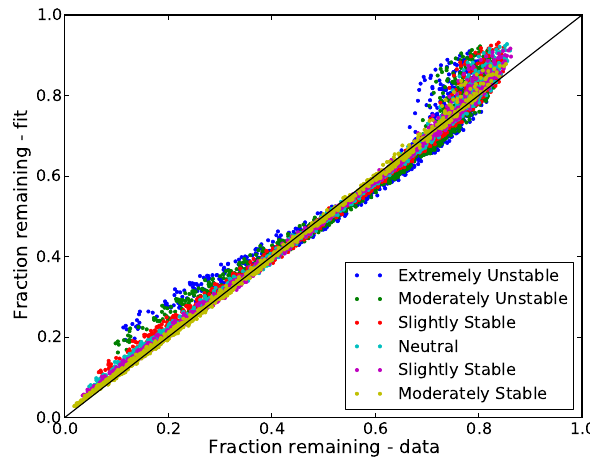
Fig. 4. The fraction of particles remaining for the parameterization (fit) compared to full Gaussian multi-shelled model results (data). The black line represents a perfect match between the fit and